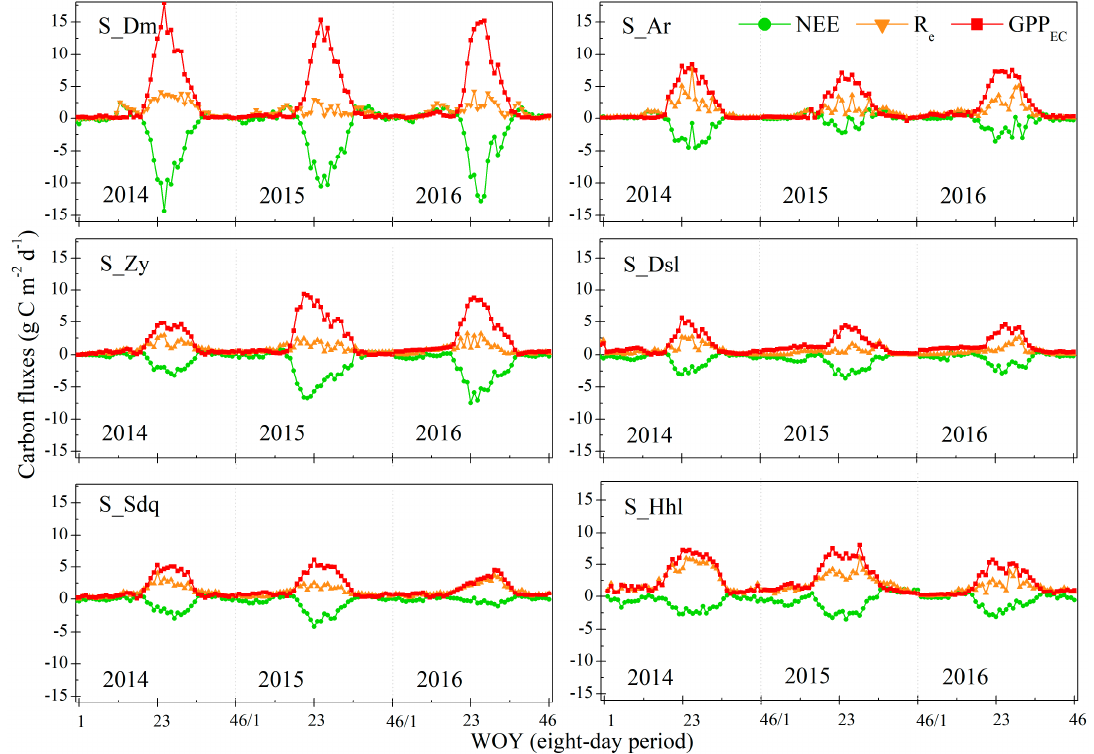
Figure 2. Seasonal variations in carbon fluxes (GPP, R e , and NEE) at the typical flux sites between 2014 and 2016 at the eight-day period. WOY means week of year.